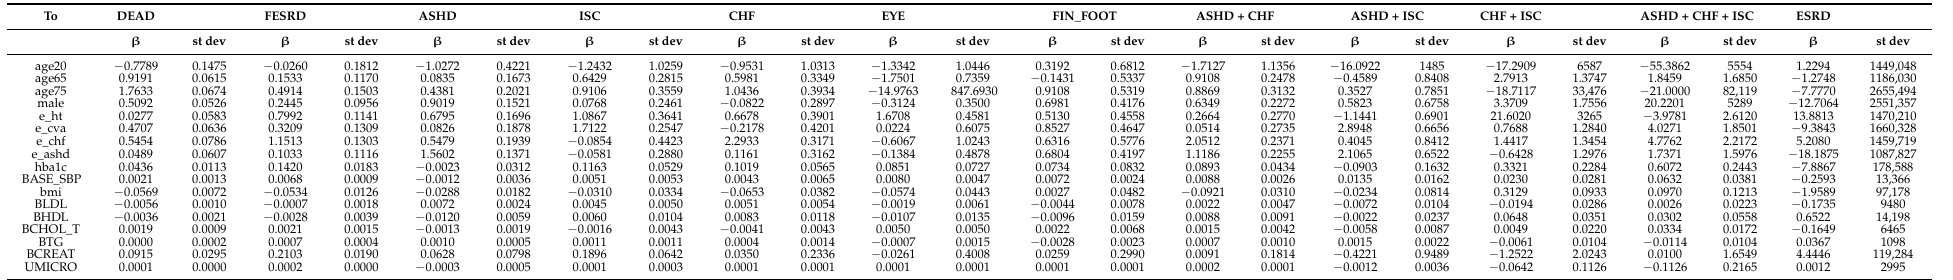
Table A3. The coefficients of linear regressions associated with each ∑ β i ( j ) x i + β HBA 1 C ( j ) × x HBA 1 C ( a , t )